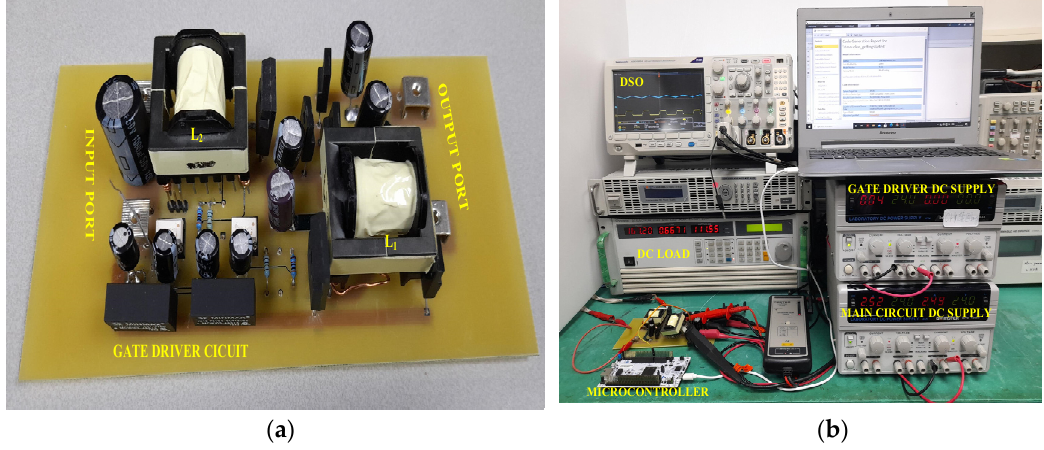
Figure 12. Proposed Converter power circuit board (PCB) Layout.